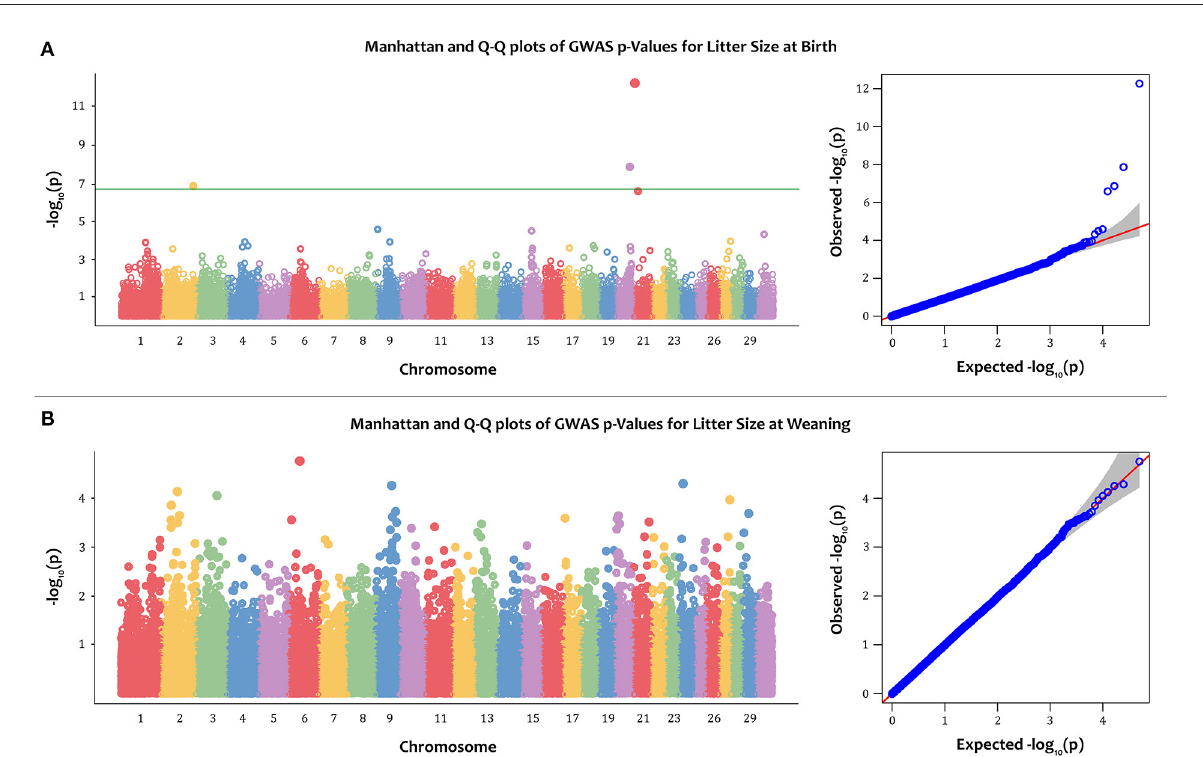
FIGURE2 The Manhattan and quantile–quantile (Q–Q) plots of -log 10 ( p -value) for litter size at birth (LSB) (A) ; and litter size at weaning (LSW) (B) in the Markhoz goats using the BLINK GWAS model. The green horizontal line indicates the FDR adjusted p -value threshold of